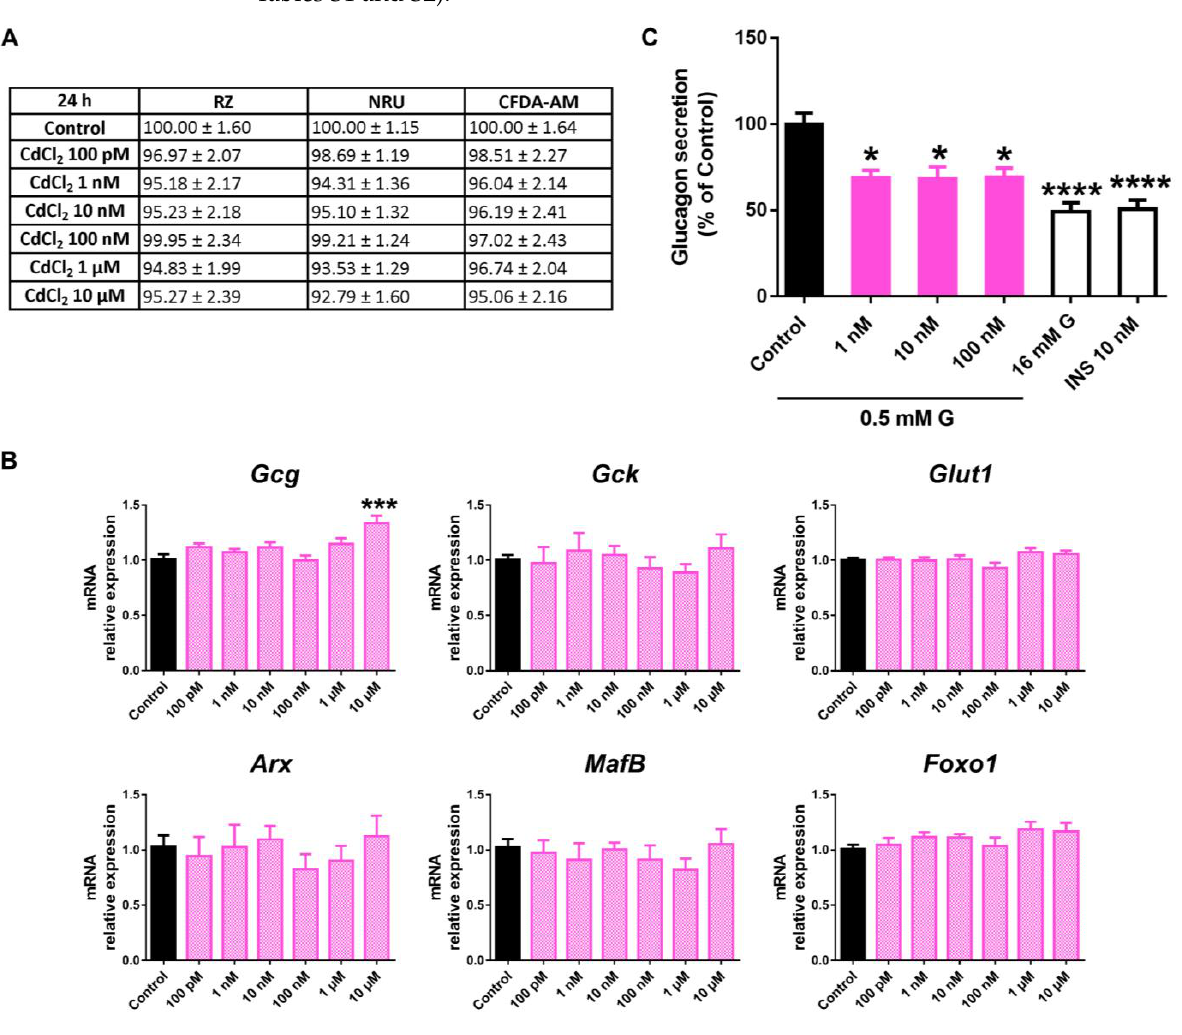
Figure 8. CdCl 2 effects on pancreatic α -cells. ( A ) Viability of pancreatic α TC1-9 cells treated for 24 h with different concentrations of CdCl 2 (100 pM – 10 μ M) as evaluated by RZ, NRU, and CFDA-AM assays. Results are expressed as % of the solvent controls (Control = 100%). ( B ) mRNA expression of Gcg , Gck , Glut1 , Arx , MafB , and Foxo1 in control- and CdCl 2 -treated α TC1-9 cells for 24 h. ( C ) Glucagon secretion in α TC1-9 cells treated for 24 h with CdCl 2 . Data are represented as mean ± SEM of ( A ) n = 3, ( B ) n = 3, and ( C ) n = 6 independent experiments. * vs. Control; * p < 0.05, *** p < 0.001, **** p < 0.0001 by one-way ANOVA followed by Dunnett ’ s post hoc test or Kruskal – Wallis followed by Dunn’s post hoc test .